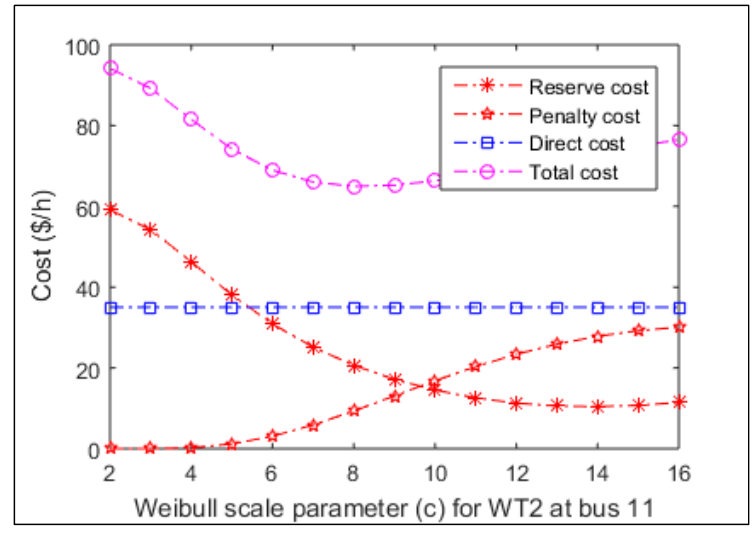
Figure 8. Cost vs. Weibull scale parameter ( c ) at bus #11.